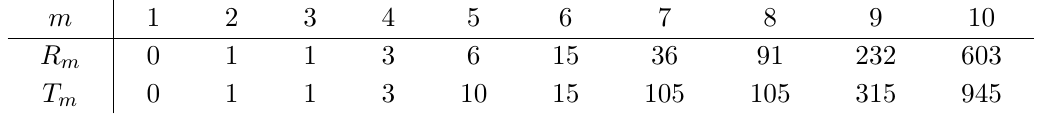
Table 5 . Given m copies of the SU(2) adjoint, the Riordan number R m is the number of independent singlets in their tensor product, while T m is the number of expressions we could construct by contracting with SO(3) invariant tensors as described in the main